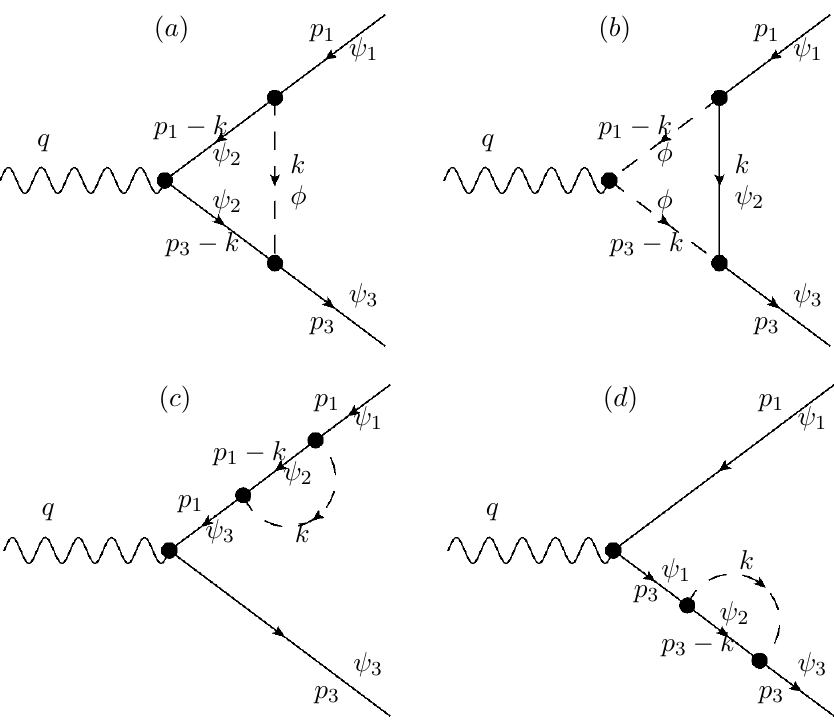
Figure 3 . Triangle diagrams that give rise to the e(cid:11)ective (cid:13)avor-changing operator. The UV divergences of these diagrams should cancel in the summation due to gauge